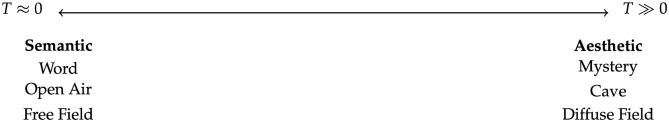
Basic continuum of Liturgical space, from the extremes of semantic to aesthetic.